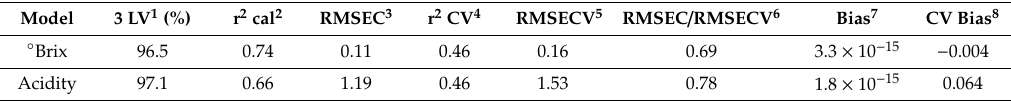
Table 1. Statistical parameters obtained by multivariate regression modeling of MicroNIR spectra with ◦ Brix and total acidity using 3